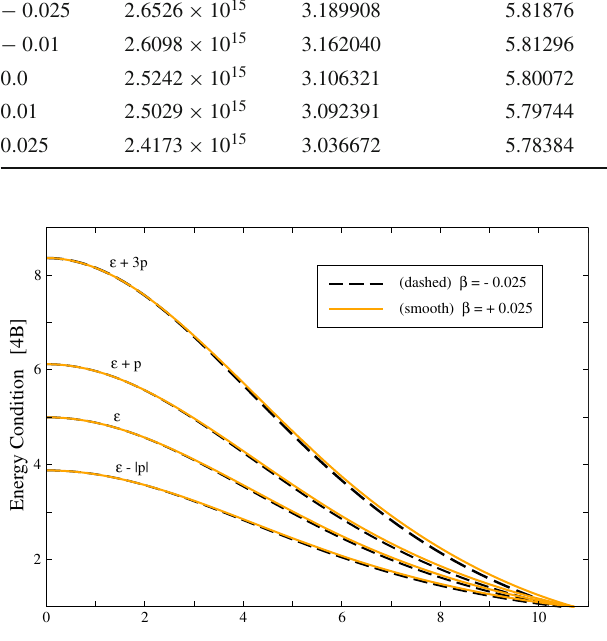
Fig. 8 Radial profiles of energy conditions (ECs): null energy con- dition ( ε ≥ 0), weak energy condition ( ε + p ≥ 0), strong energy condition ( ε + 3 p ≥ 0), and dominant energy condition ( ε − | p | ≥ 0)